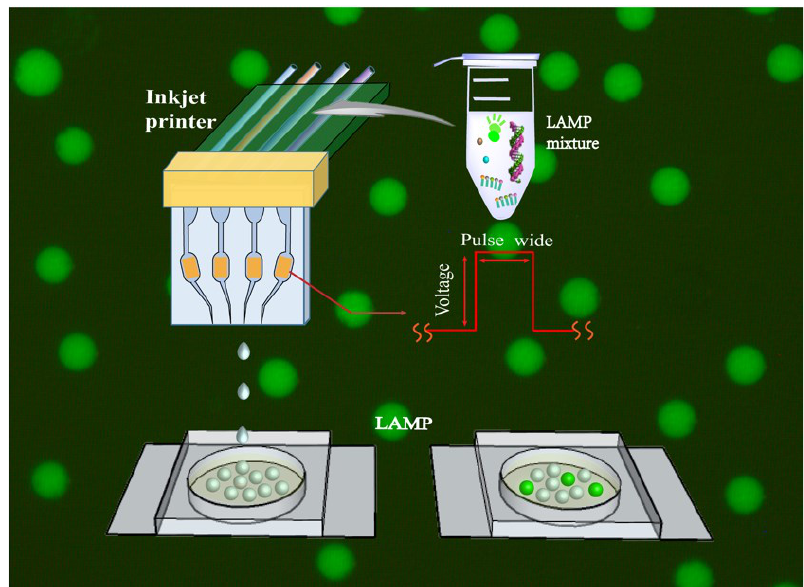
Figure 1. Schematic illustration of the self-assembled inkjet printer for droplet digital loop-mediated isothermal amplification. (Not real scale).